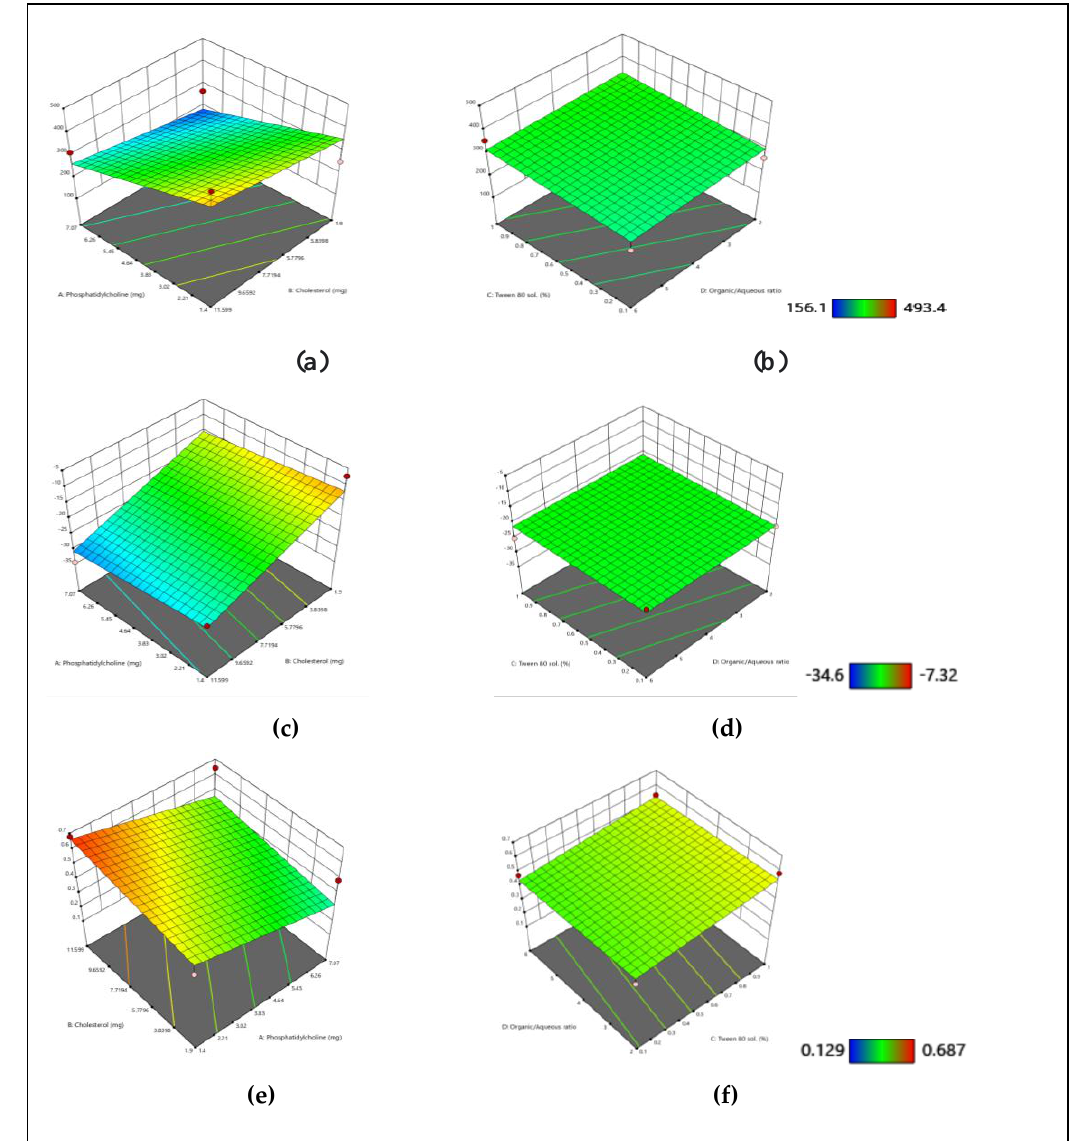
Figure 1. 3D graphical representation of variables including PC, cholesterol, Tween 80 solution (%), and organic to aqueous ratio on responses particle size ( a , b ), zeta potential ( c , d ), and PDI ( e , f ).